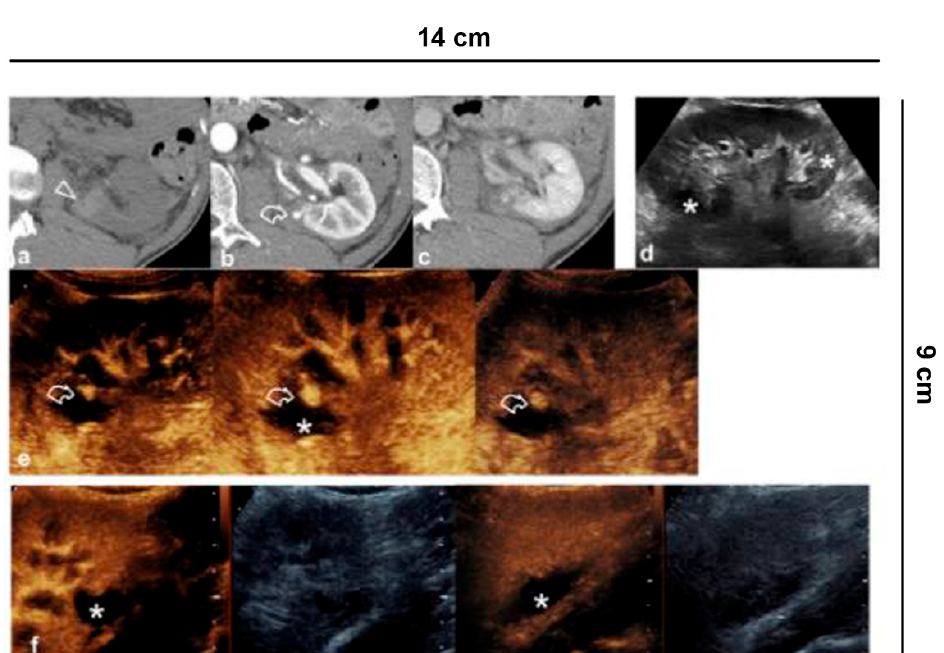
Figure 9. Vascular lesions. 35-year-old male patient with abdominal trauma treated conservatively. ( a ) CT without contrast medium shows parenchymal hyper-density from recent hematoma (arrowhead) at the lower pole of the left kidney; ( b ) A pseudoaneurysm (curved arrow) is recognized in the arterial phase, while in the ( c ) nephrographic phase the parenchymal contusion is more clearly recognized and the pseudoaneurysm is less visible; ( d ) B-mode US shows inhomogeneous echogenic areas (asterisks) corresponding to the contusions; ( e ) CEUS adequately shows all the vascular phases of the pseudoaneurysm (curved arrow) and the perirenal hematoma (asterisk); ( f ) Follow-up performed on 7th day.